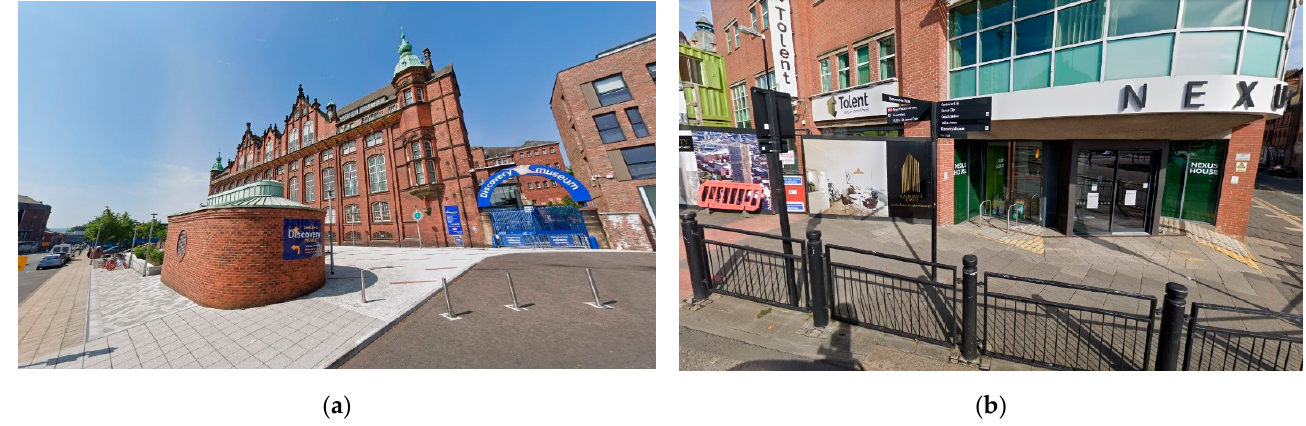
Figure 3. Elements of the built environment in Newcastle-upon-Tyne. Source: Google Street View, 2021. ( a ) The Discovery Museum is a museum from the Tyne and Wear Archives and Museums network. It holds a historic and scientific program, set in an ancient building from the XIX century from the Cooperative Wholesale Society. The main access has been refurbished creating a pedestrian entry. In the interior, the building is adapted according to universal accessibility criteria. ( b ) Across Newcastle’s streets it is usually easy to find signposts which indicate directions to the main buildings of the city. Also, informative panels can be found to better help wayfinding in the